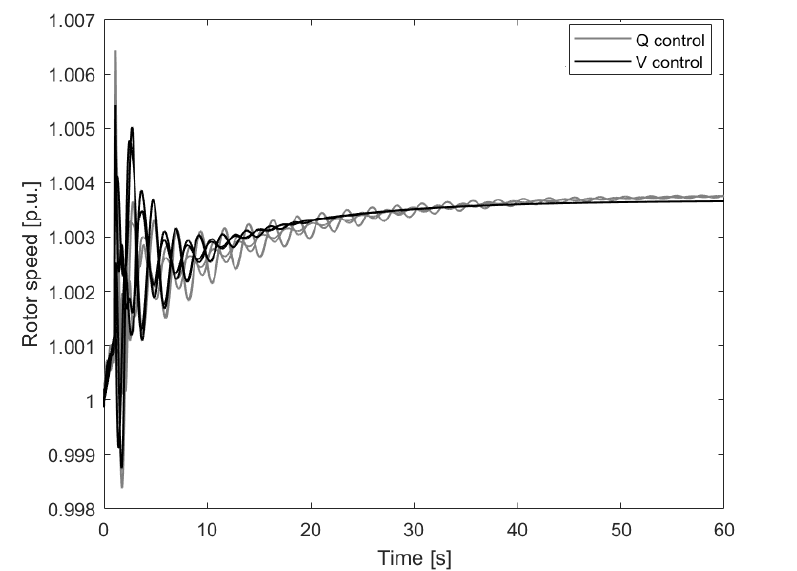
Figure 10. Time domain simulation comparing Q and V control.